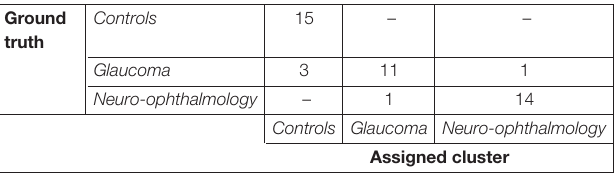
TABLE 4 | Confusion matrix for the clustering analysis on the gaze data from the screen-based eye tracker. Ground